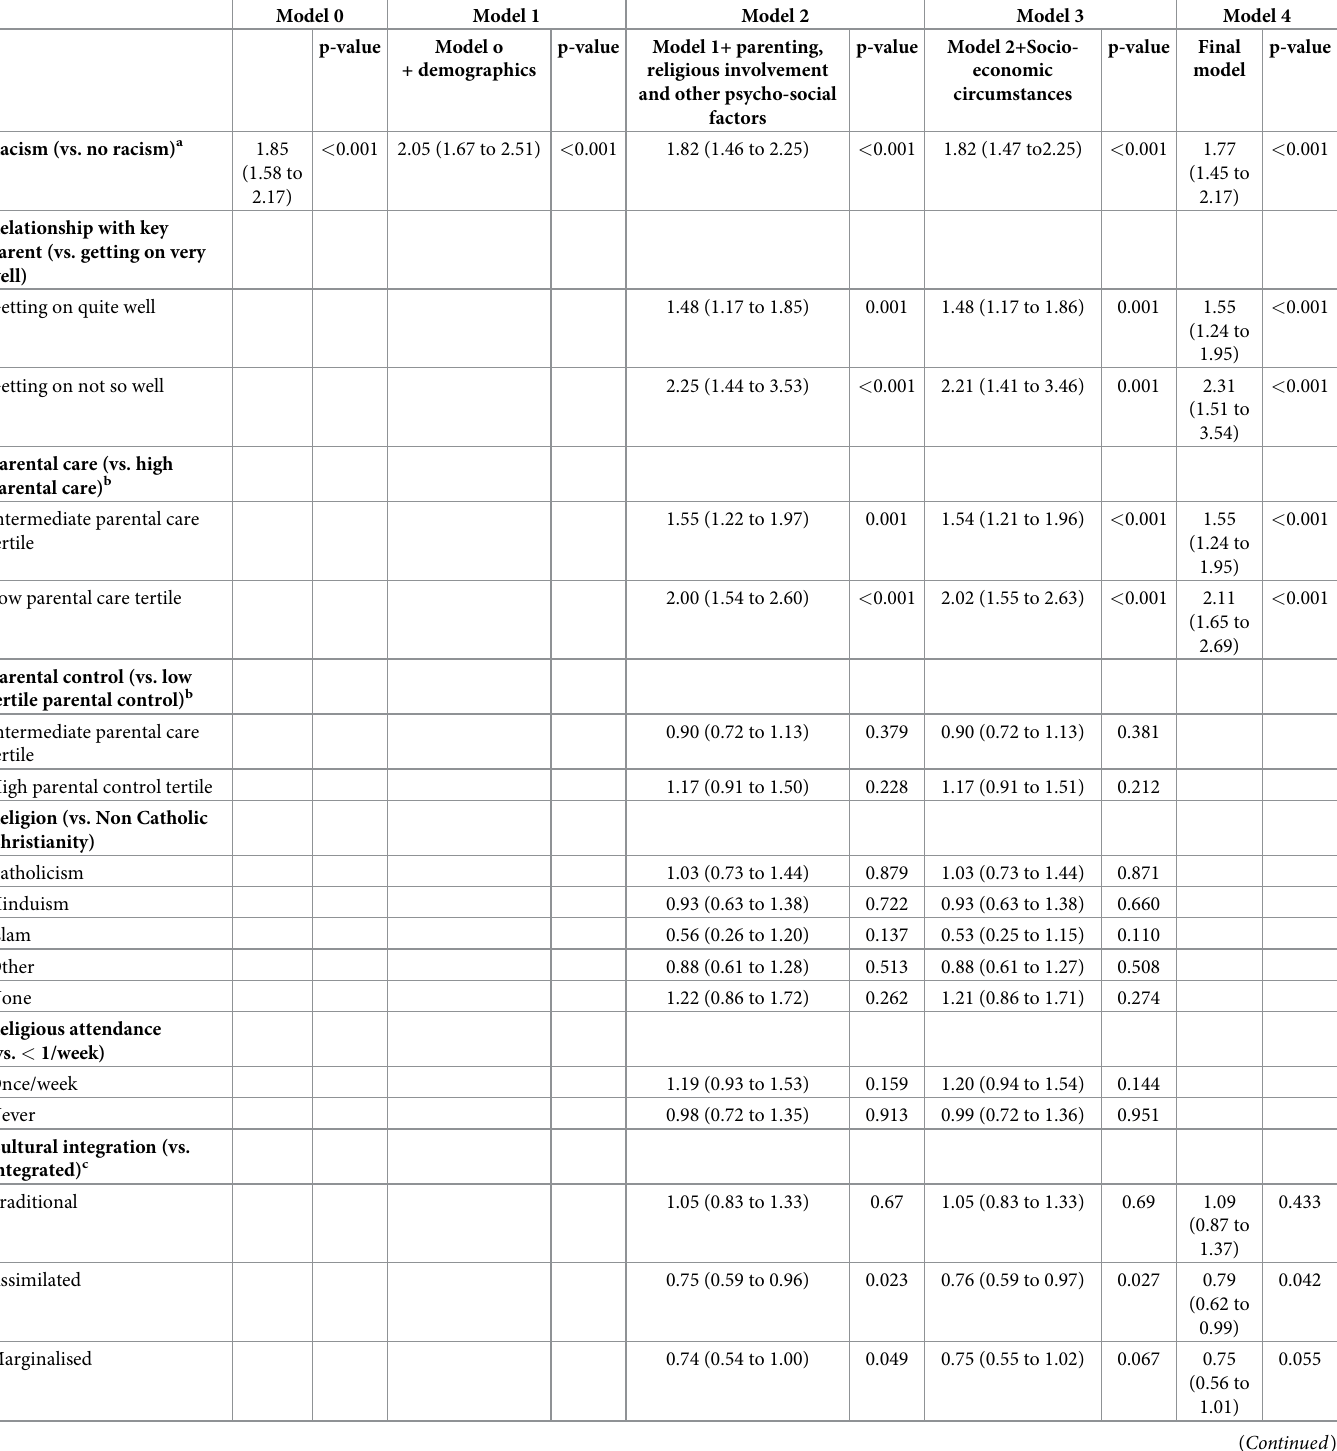
Table 4. Ever smoking at 11-16y: The influence of racism, ethnicity, parenting and religious involvement, socio-economic circumstances: Odds ratio (95% confi- dence interval). The Determinants of Adolescent (now Adult) Social well-being and Health